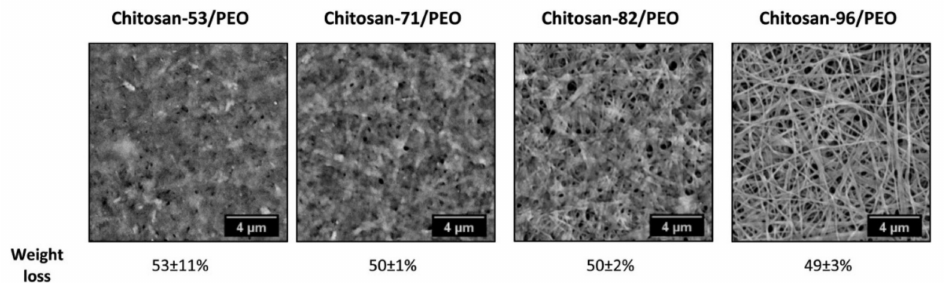
Figure 30. Aqueous stability of CS/PEO nanofibers electrospun with CS of various DDA. Represen- tative SEM images (dry) and weight loss of CS/PEO nanofibers electrospun with CS of various DDA (53%, 71%, 82%, or 96%) after exposure to water for 3 h. 10,000 × magnification [230]. Reproduced with permission from Elsevier